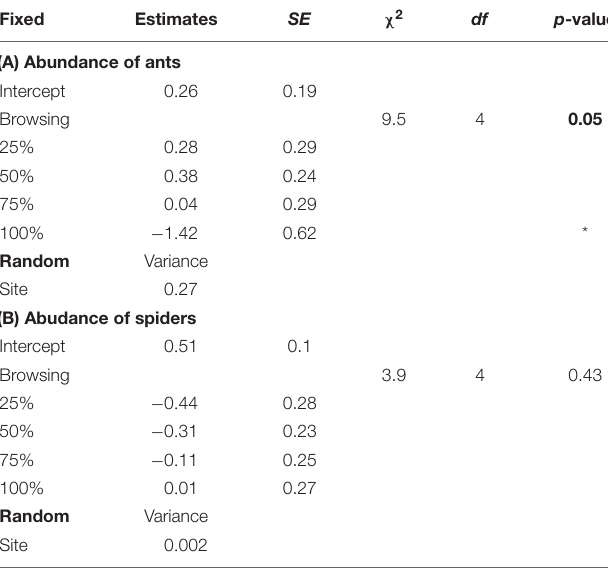
TABLE 2 | ANOVA (type II test) and summary table for generalized linear mixed effects models testing the difference in abundance of (a) ants and (b) spiders, in relation to browsing